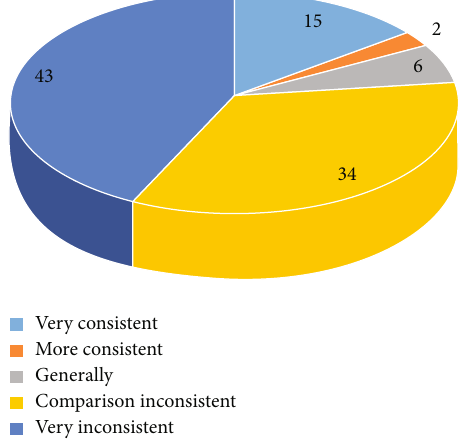
Figure 3: Analysis of impression consistency before and after